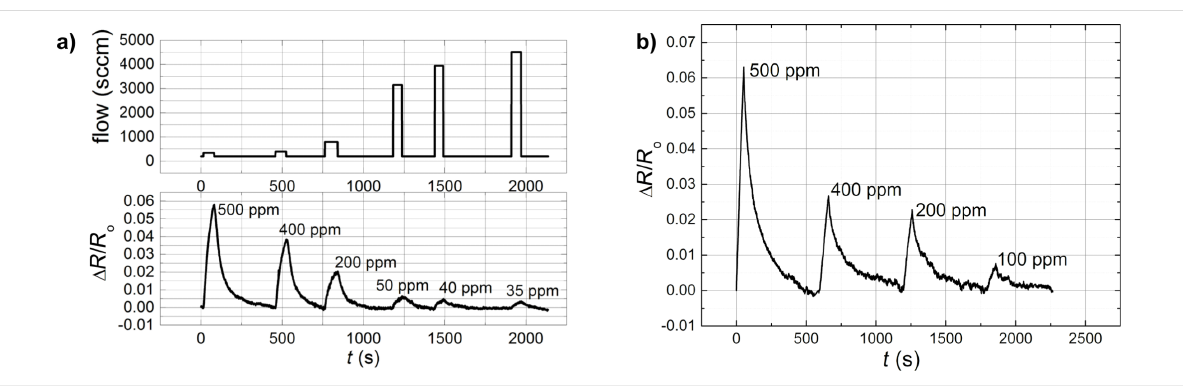
Figure 6: Relative change of the electrical resistance of EVA–CB (7.75 phr CB) as a function of time in a) toluene and b) m -xylene vapours (60 s exposure) for various vapour concentrations. Sample thickness is 50 µm.